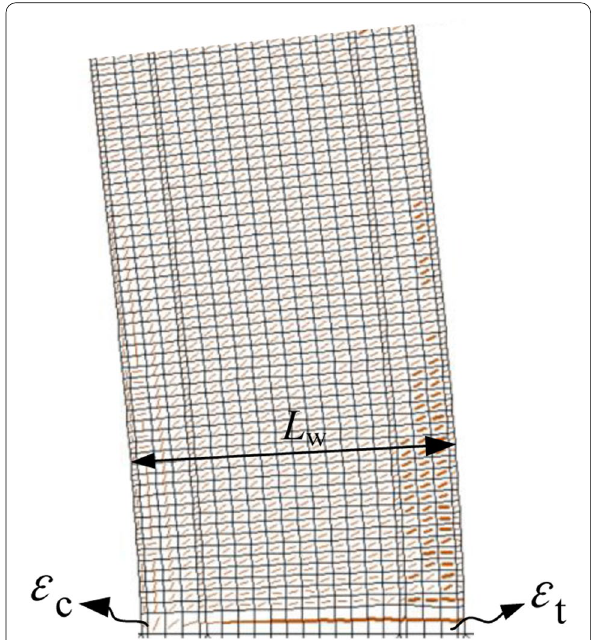
Fig. 10 Calculation of curvature based on the finite element analysis.